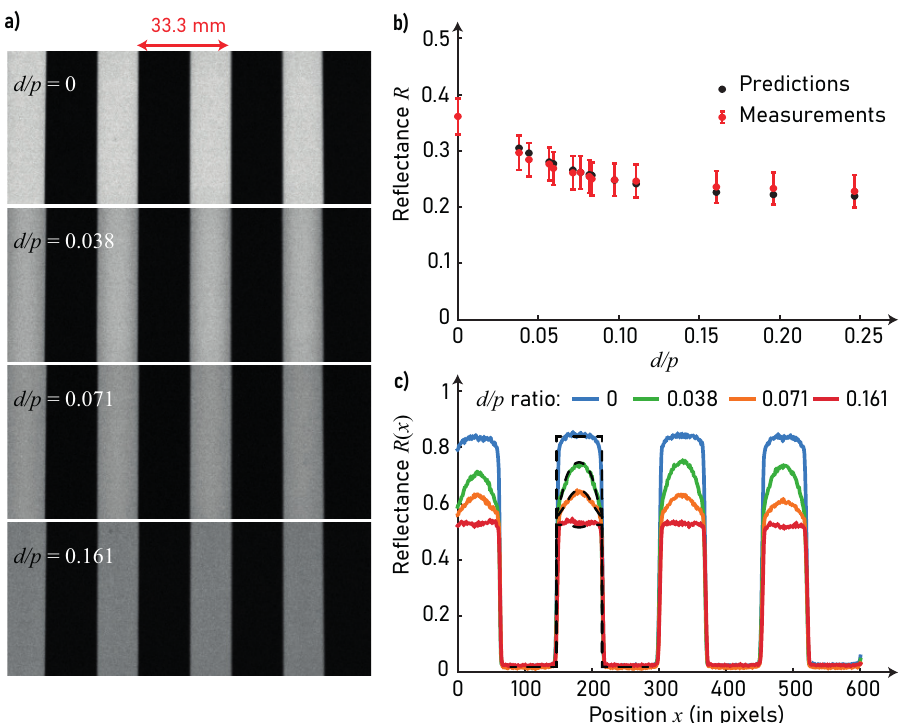
Figure 5. ( a ) Pictures of the halftone pattern when uncovered and covered by a layer of clear liquid (optical index of 1.5) with increasing thickness, yielding four different d/p ratios; ( b ) comparison between measured and predicted reflectances of the coated support for different d/p values; ( c ) re- flectance profiles extracted from the images displayed in ( a ) for the different d/p values (colored solid lines) and profiles predicted by the model for the same d/p values and the same reflectance values on the uncoated support (black dashed